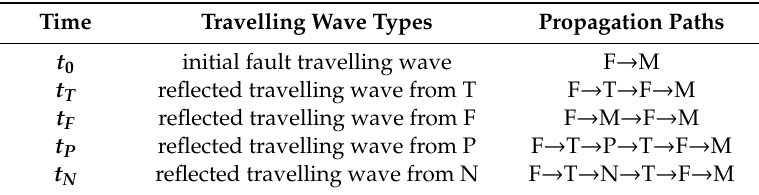
Table 3. Travelling wave types with their reach times.